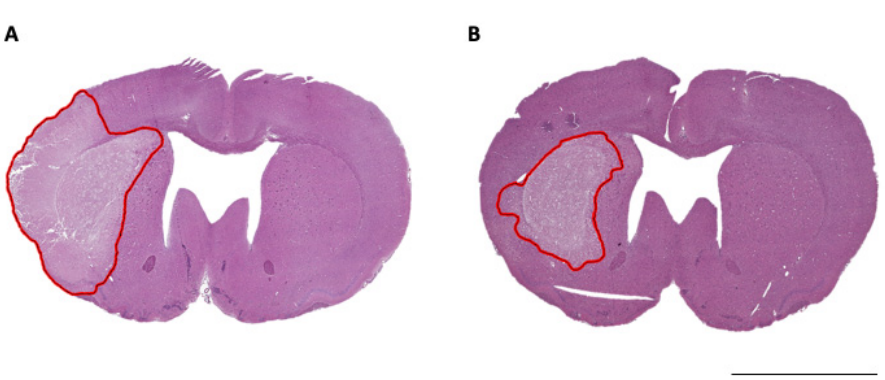
Figure 3. Representative H&E-stained brain sections of ( A ) normothermia and ( B ) hypothermia treated animals. Red line indicates area of infarction. Scale bar = 4 mm.